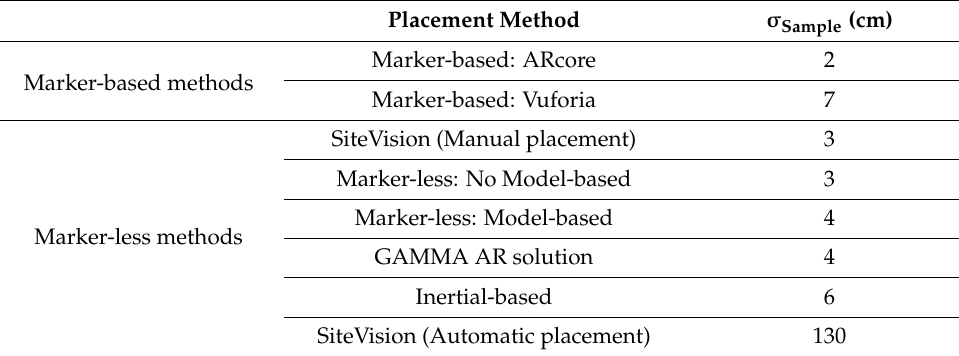
Table 3. The stability of the AR placement methods.